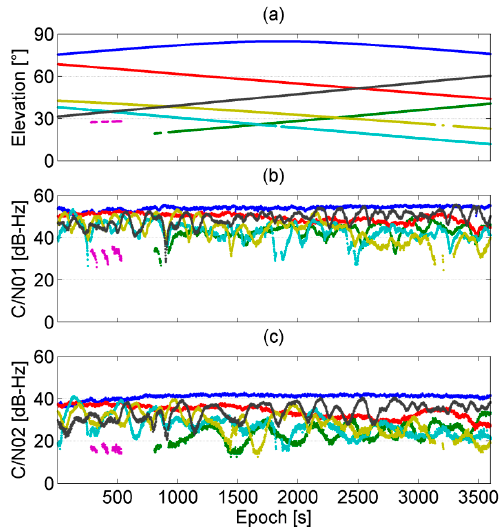
Figure 10. ( a ) Elevations of used satellites; ( b ) C/N0 of C1 (CN01) of used satellites; and ( c ) C/N0 of P2 (CN02) of used satellites. Each color denotes one satellite calculated from dataset no. 1.